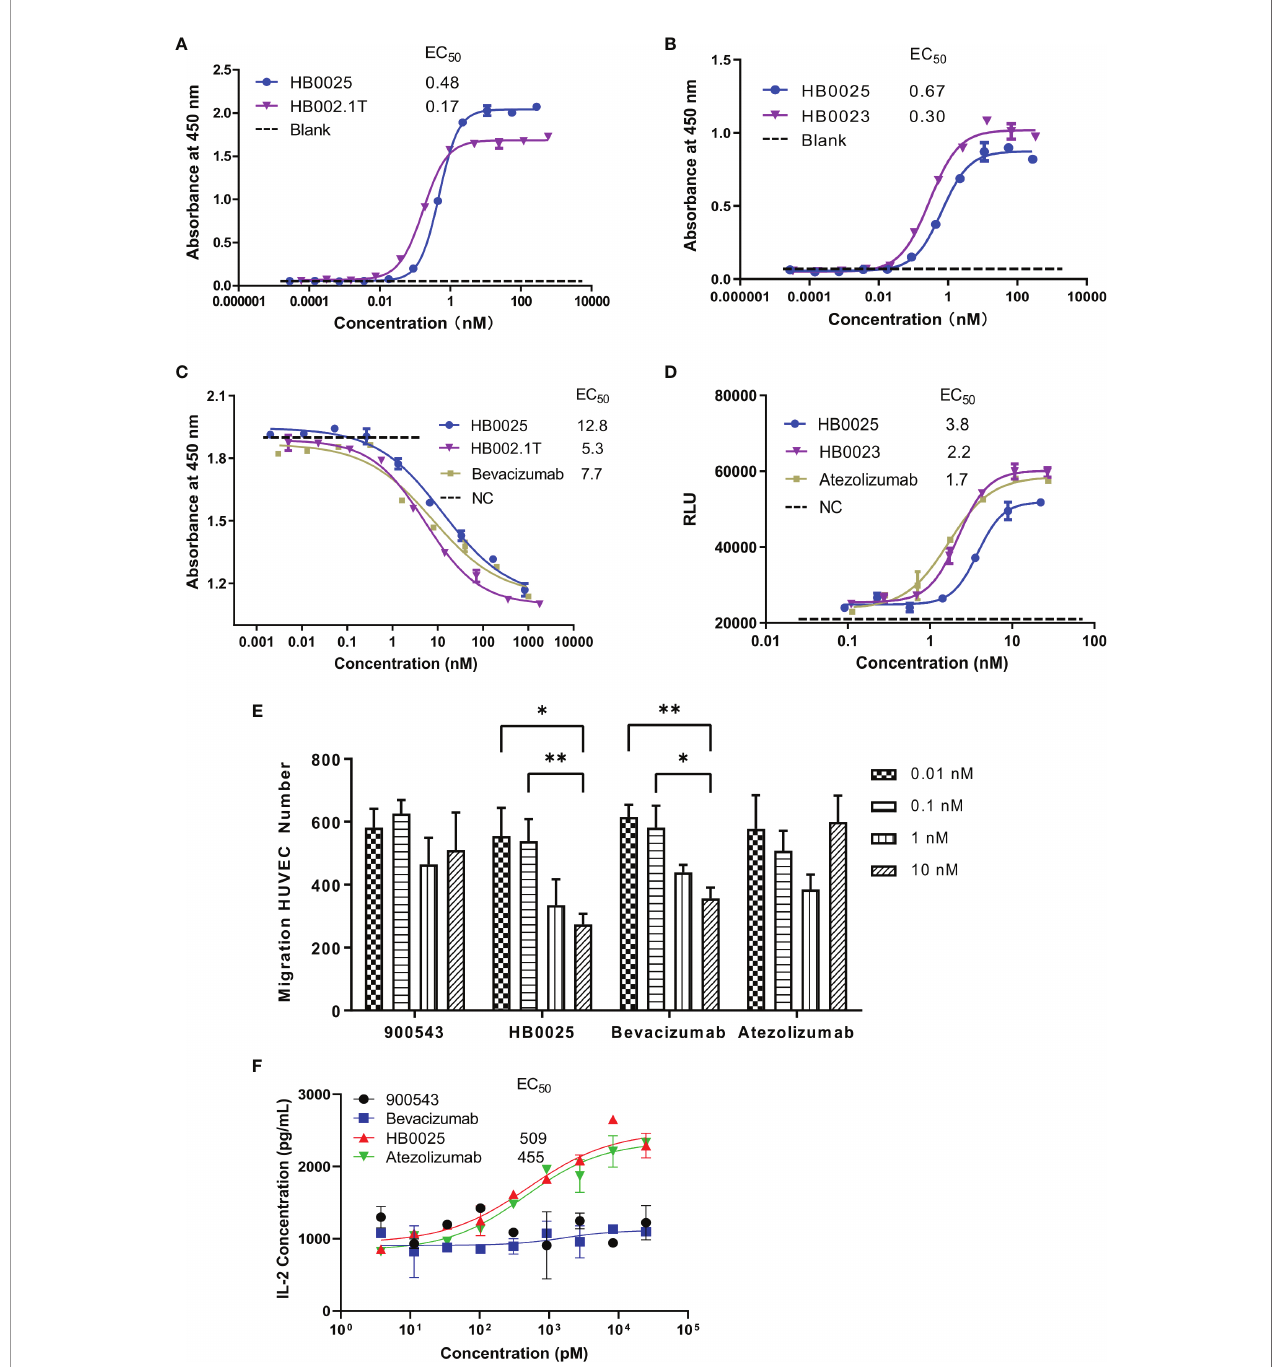
FIGURE 2 | The pro fi le of binding af fi nity and blocking activity of HB0025, the parent molecules, and the market antibodies. (A) The ELISA binding activity of HB0025 and HB002.1T to VEGF. (B) The ELISA binding activity of HB0025 and HB0023 to PD-L1. The PBST was used as a blank sample. (C) The blockade effect of HB0025, HB002.1T, and bevacizumab on VEGF-induced HUVEC proliferation by the CCK-8 assay. Negative control (NC): The cells were treated with the mixture of VEGF solution and detection medium in the ratio of 1:1. (D) Inhibitory effect of HB0025, HB0023, and atezolizumab on the PD-L1 pathway by the luciferase reporter gene system. Negative control (NC): The cells were treated with a second antibody alone. (E) Inhibition of HUVEC migration by 900543 (negative control), HB0025, atezolizumab and bevacizumab (positive control); 0.01 nM and 0.1 nM were compared with 10 nM, *p < 0.05, **p < 0.01. (F) The dose-effect fi tting curve of antibodies on the recovery of human IL-2 secretion, taking 900543 as the negative control. The data are representative of mean ± SEM; Experiments of (A – D, F) were performed in duplicate; data of Experiment E were derived from 5 visual fi